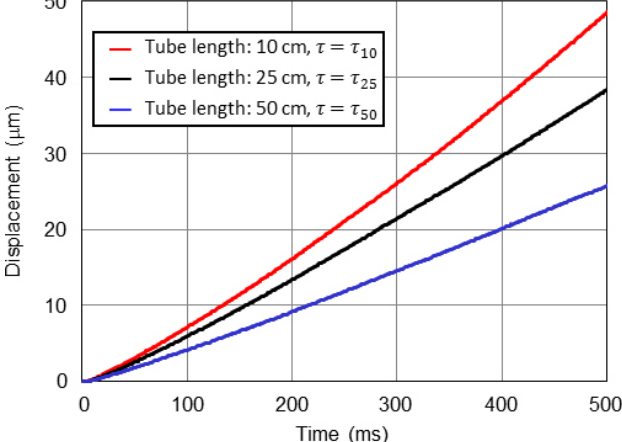
Figure 4. The measured cell position when a step input of δ syringe